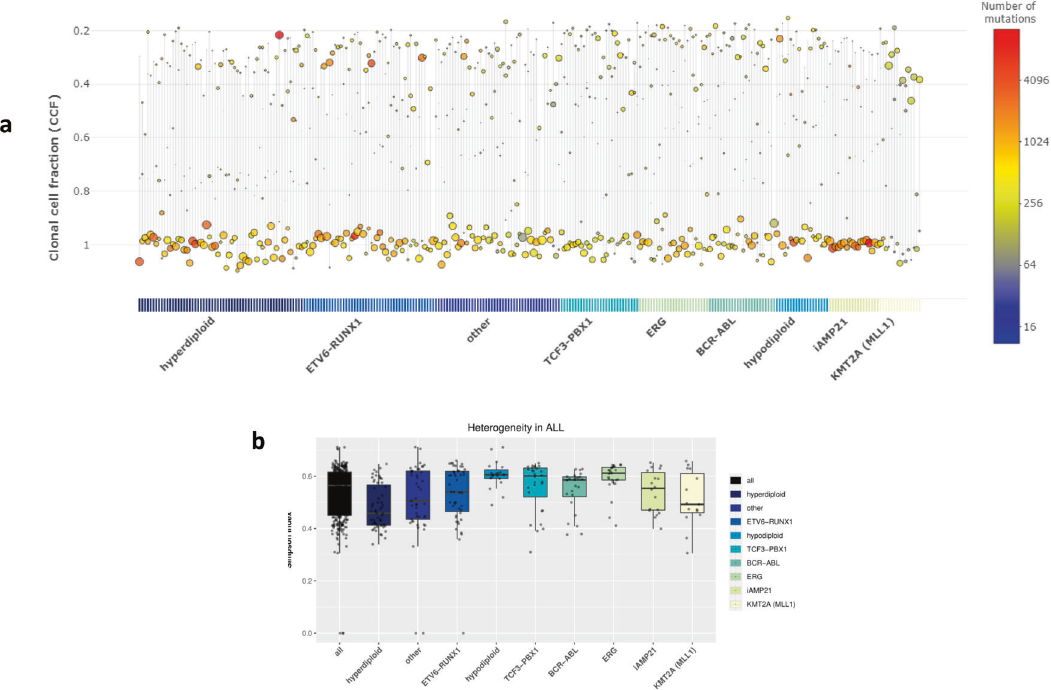
Fig. 7 Clonal architecture and evolution. Variant cancer cell fractions (CCF) were calculated and variants clustered into clonal and subclonal populations. a Distribution of clones. Horizontal lines represent single tumours, circles represent clones; the size and colour of circles corresponding the proportion and number of variants assigned to each clone. Y-axis; clonal frequency (proportion of cell cells with a variant (s)). b Heterogeneity between subtypes. Box and whiskers plot of Simpson index (higher values indicative of increased heterogeneity). Each dot corresponds to a